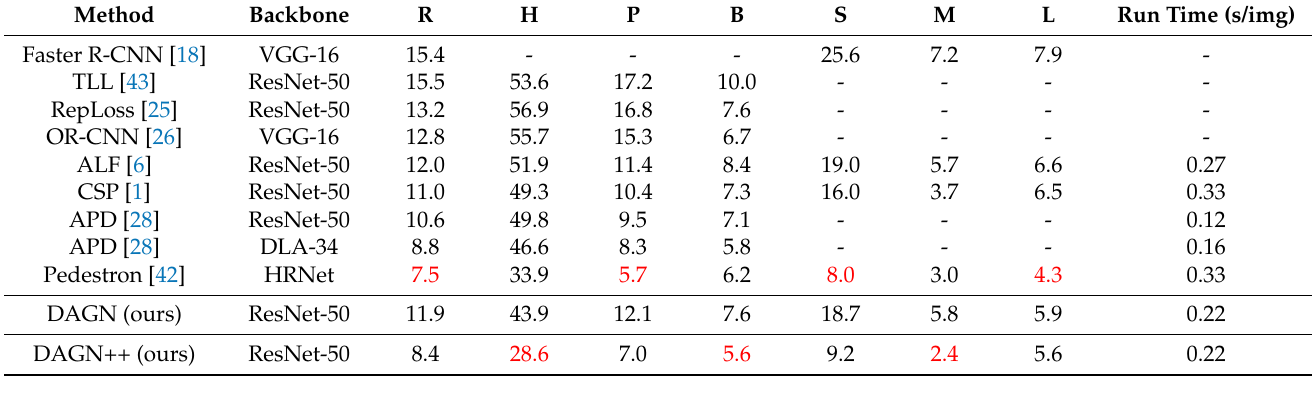
Table 4. Comparisons with the state-of-the-art methods of the CityPersons validation set. R, reasonable; H, heavy occlusion; P, partial occlusion; B, bare; S, small scale; M, medium scale; and L, large scale. Red color values denote the best results.